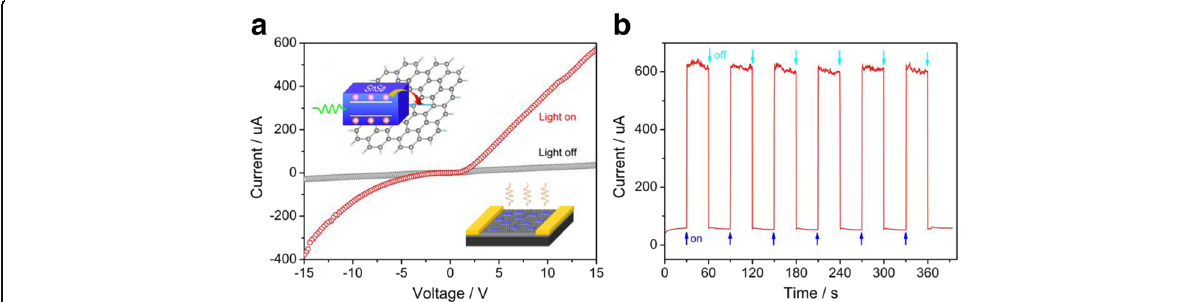
Fig. 6 a The typical I-V characterization of the photodetector device constructed with the SnSe nanoplate-graphene nanocomposites, the schematic and structural diagram of the photodetector shown in the left upside and right downside inset ; b the photosensitivity of the photodetector device with the voltage of 15 V under the white light or